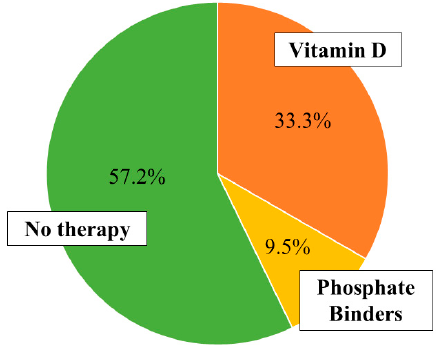
Table 11. Other biological markers of healthy subjects.